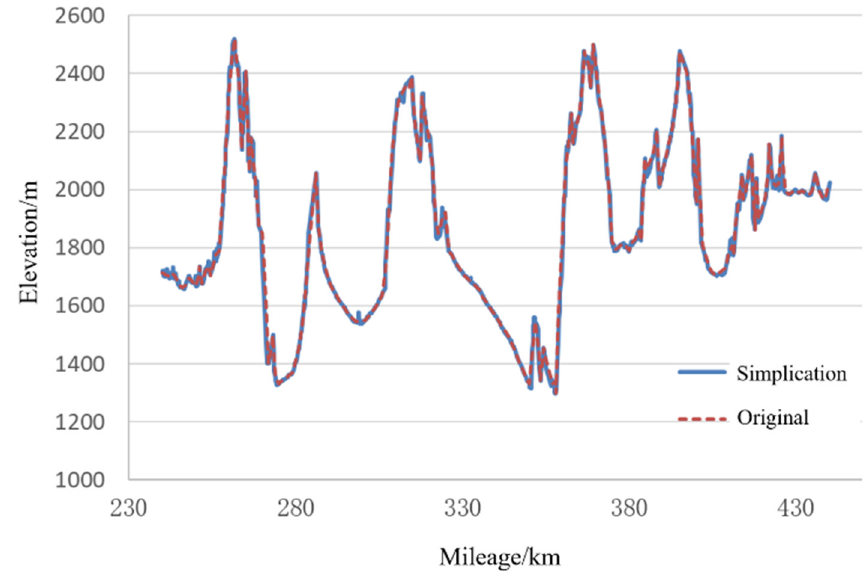
Figure 6. Simplified diagram of a section of the crude oil pipeline in China.